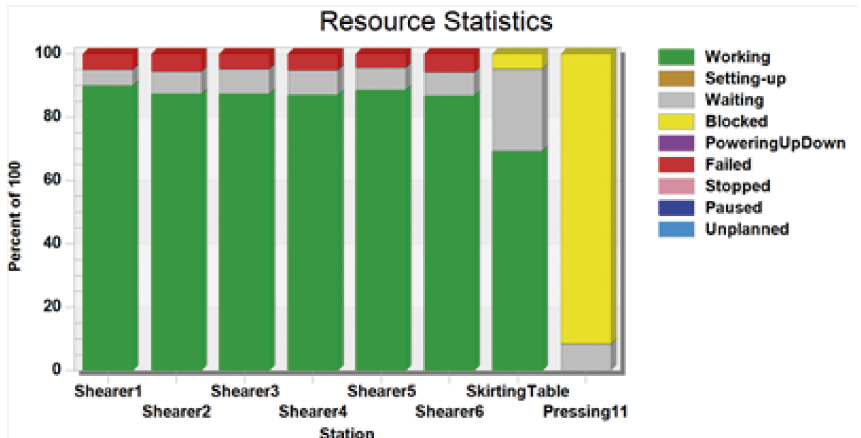
Figure 10. Resource statistics for skirting process time equal to 22